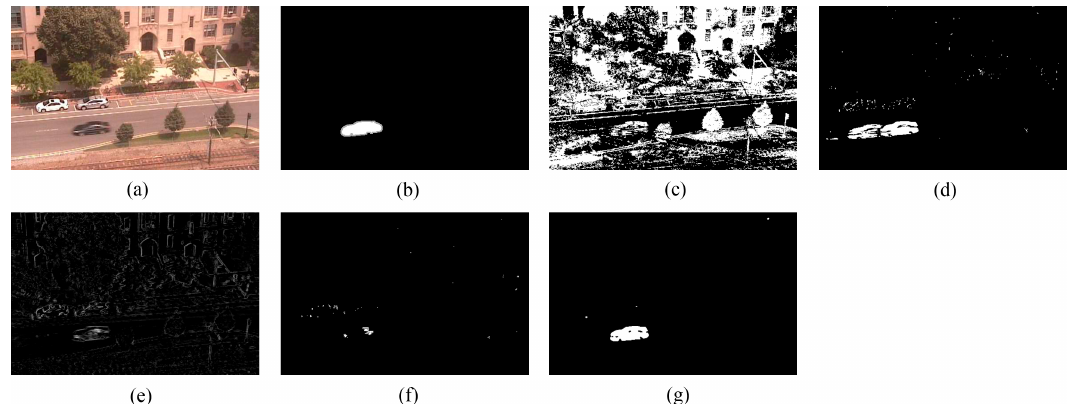
Figure 11. Detection results of the 89th frame of TP96 (Frame 888): ( a ) input frame; ( b ) ground-truth reference; ( c ) result of ViBe; ( d ) result of PCP; ( e ) result of TD-2DDFT; ( f ) result of TD-2DUWT; ( g ) result of TD-3DDWT.